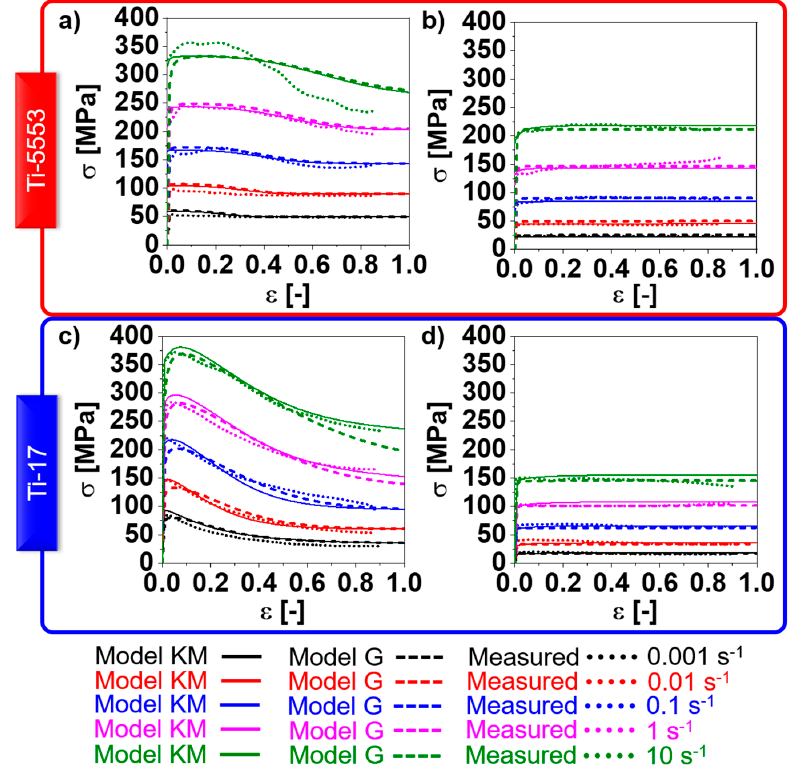
Figure 5. Simulated flow curves using the “Model KM” and the “Model G” compared to the measured ones for ( a , b ) Ti-5553 and ( c , d ) Ti-17 at ( a ) 800 °C, ( b ) 920 °C, ( c ) 810 °C, and ( d ) 970 °C.